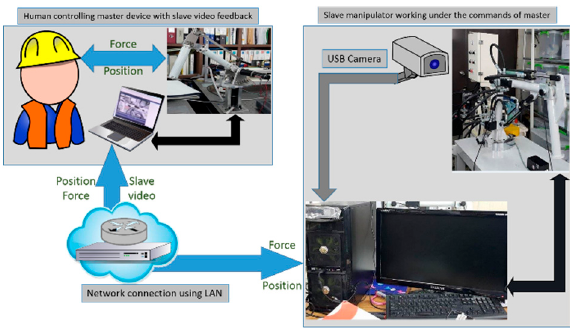
Figure 3. Schematic diagram of tele-operation.